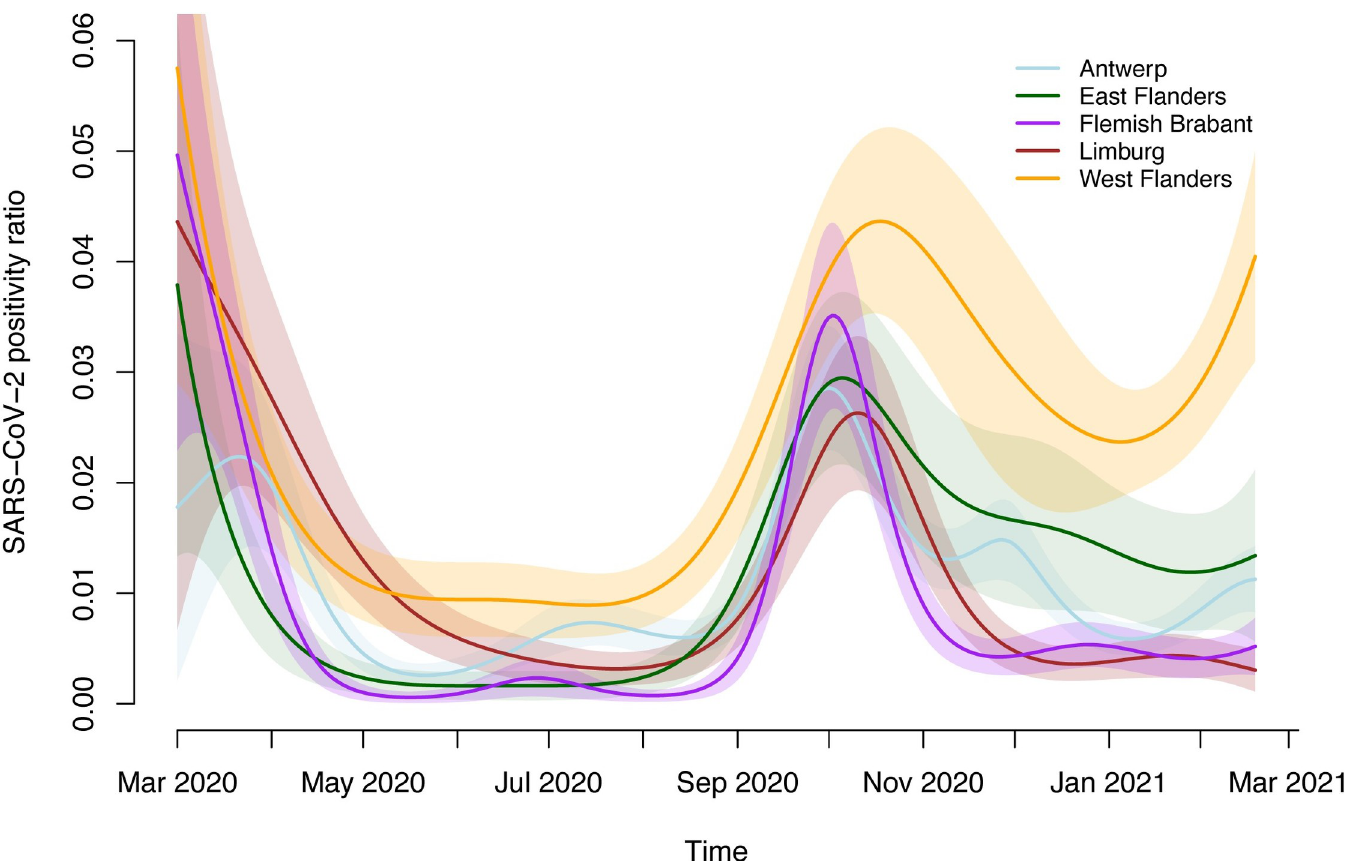
Fig 5. Estimated evolution of the SARS-CoV-2 real-time RT-PCR positivity ratio in a-/pre-symptomatic patients screened pre-hospitalization/pre-surgery by province for individuals aged 54 years (median age of screened patients) together with pointwise 95% confidence bounds (shaded areas).